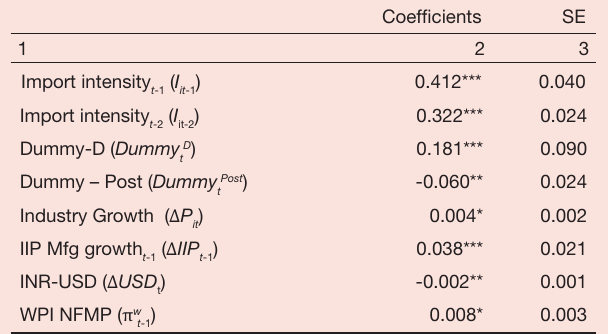
Table 1: Parameter estimates